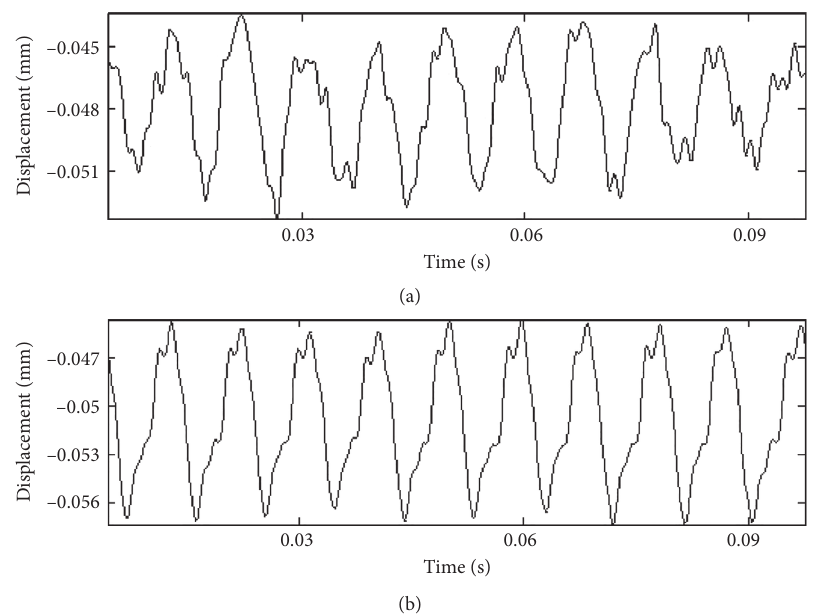
Figure 21: Radial position of the rotor when the rotor was running at 6000rpm. (a) x -axis position of the rotor. (b) y -axis position of the rotor.